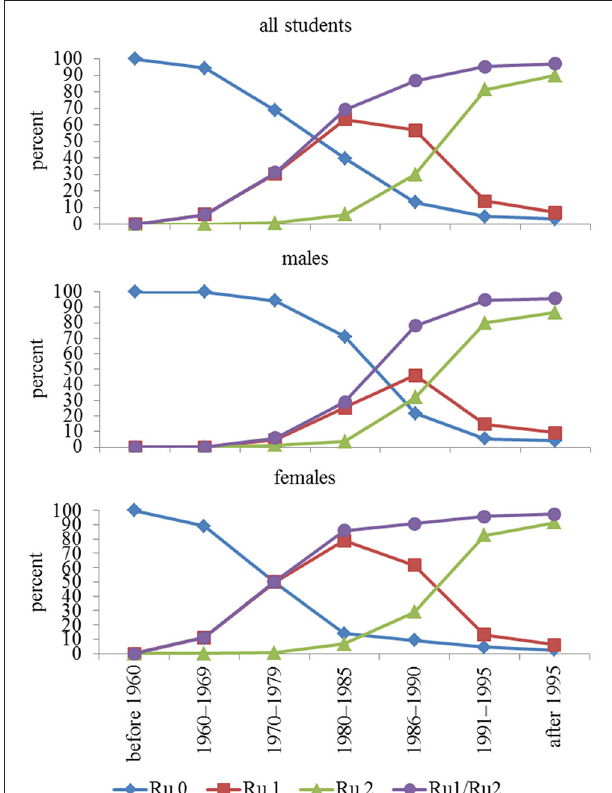
FIGURE 1 | Compliance with rubella vaccination in relation to year-of-birth group. In addition to no vaccination, one dose, and two doses, a fourth option is receiving the vaccine (regardless of whether one or two doses). Ru = rubella, Ru 0 = unvaccinated, Ru 1 = one dose, Ru 2 = two doses, Ru1/Ru2 = vaccinated once and twice considered